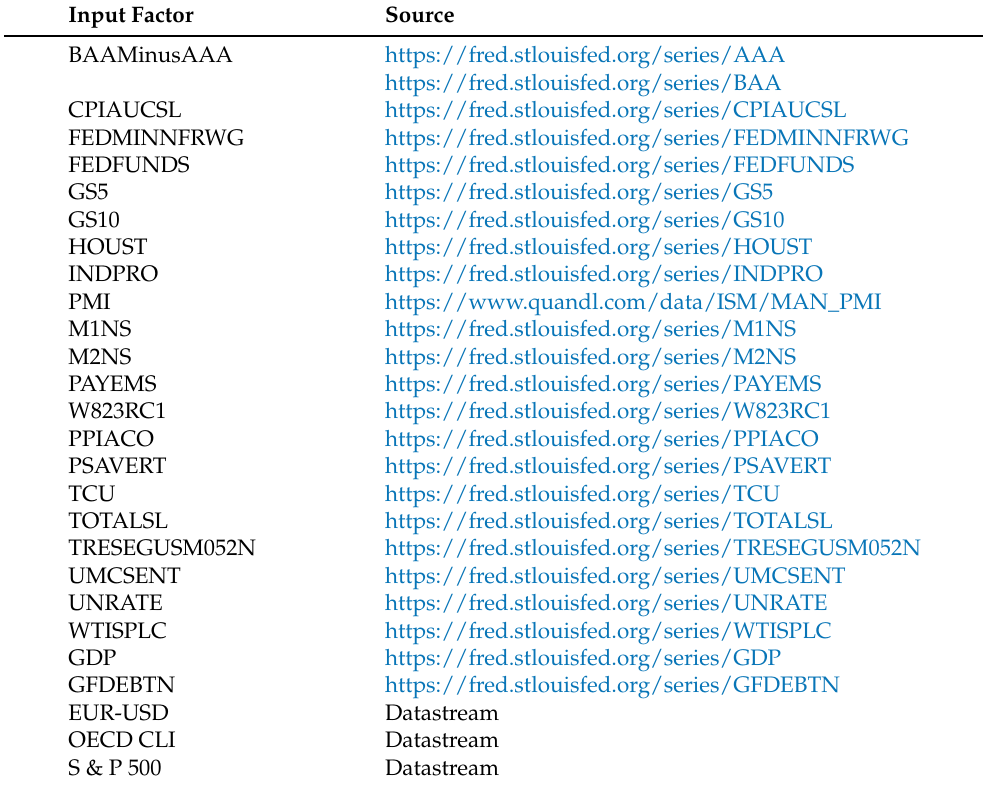
Table A1. Sources of the Input Factors. Accessed in 20 June